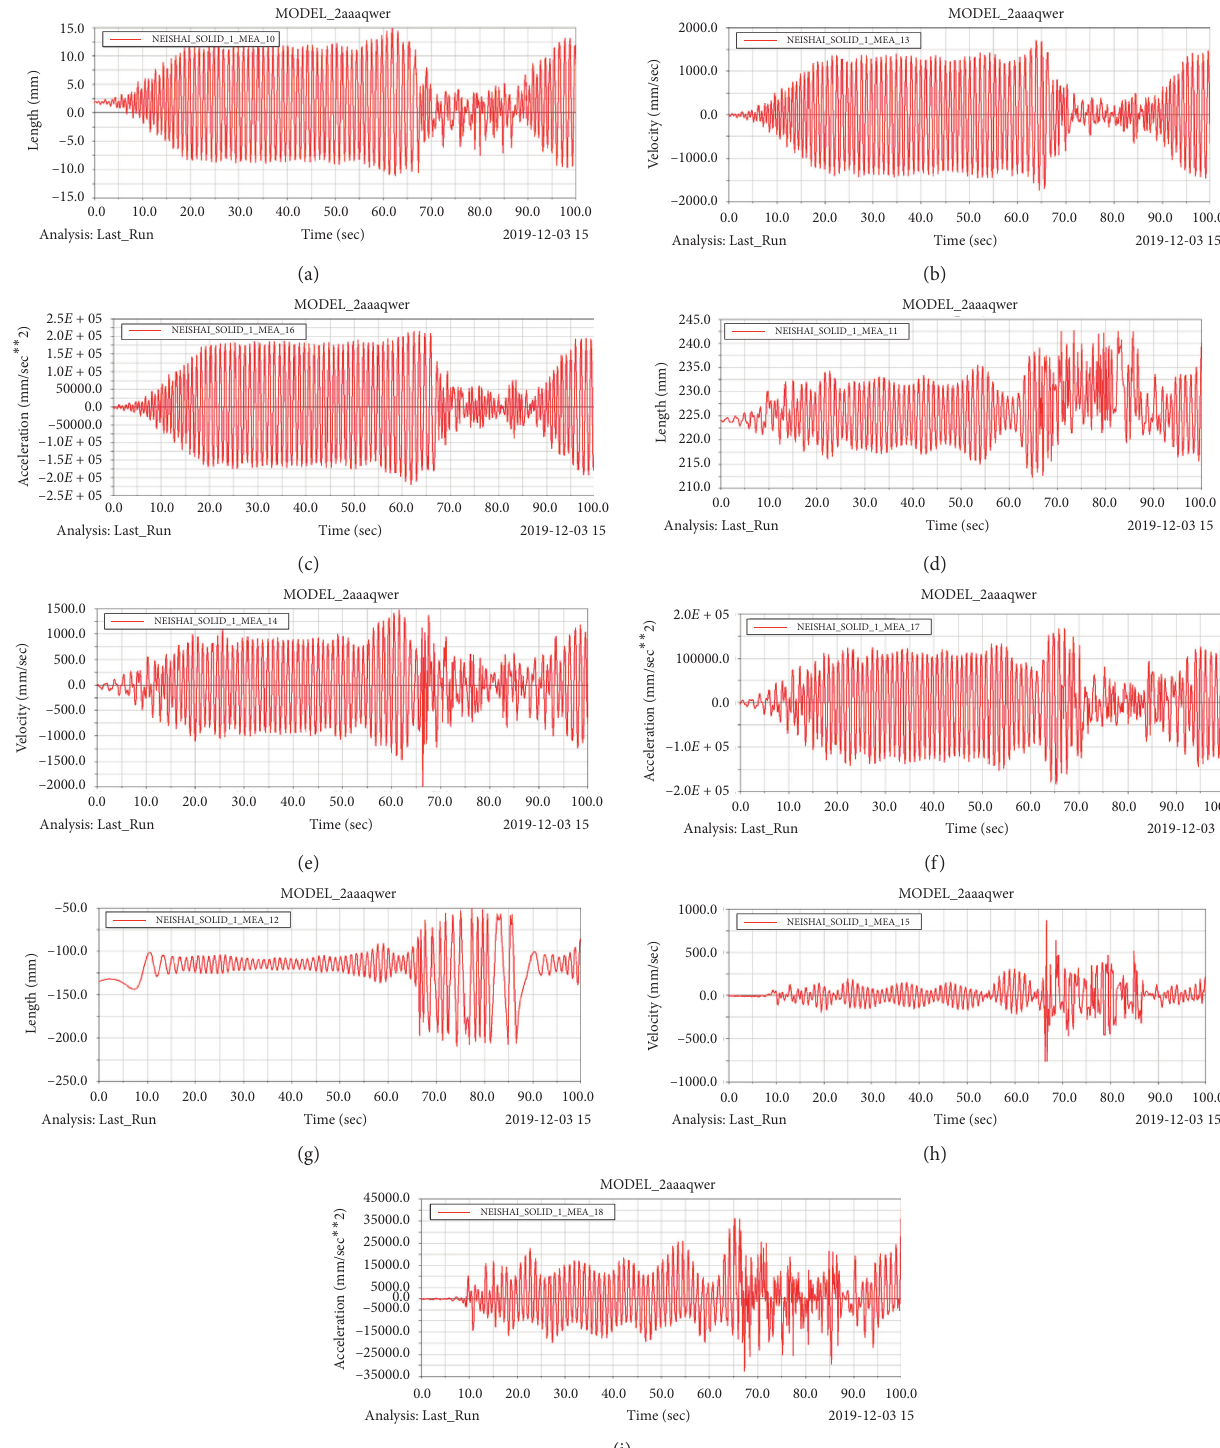
Figure 9: Dynamic simulation results of the outer screen frame of the 4-DOF chaotic vibrating screen. (a) Amplitude curve in the X - direction, (b) velocity curve in the X -direction, (c) acceleration curve in the X -direction, (d) amplitude curve in the Y -direction, (e) velocity curve in the Y -direction, (f) acceleration curve in the Y -direction, (g) amplitude curve in the Z -direction, (h) velocity curve in the Z - direction, and (i) acceleration curve in the Z